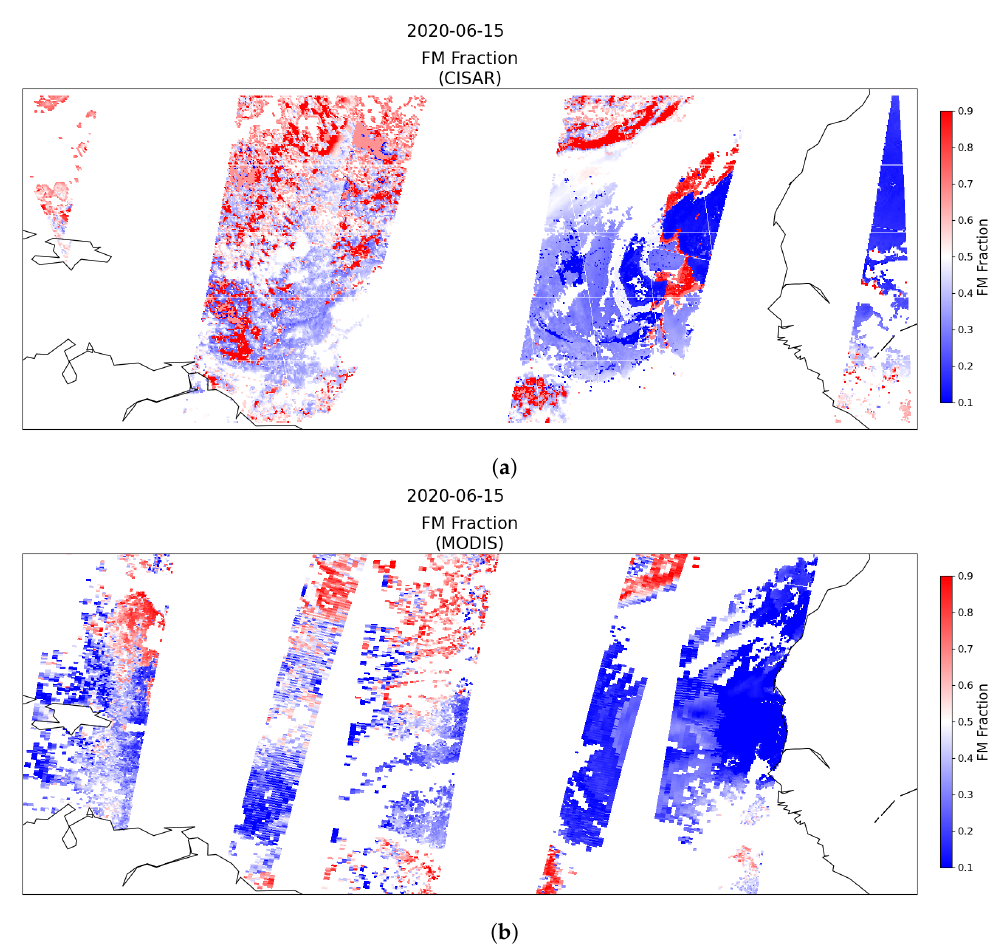
Figure 10. FM fraction associated to the CISAR ( a ) and MODIS ( b ) aerosol